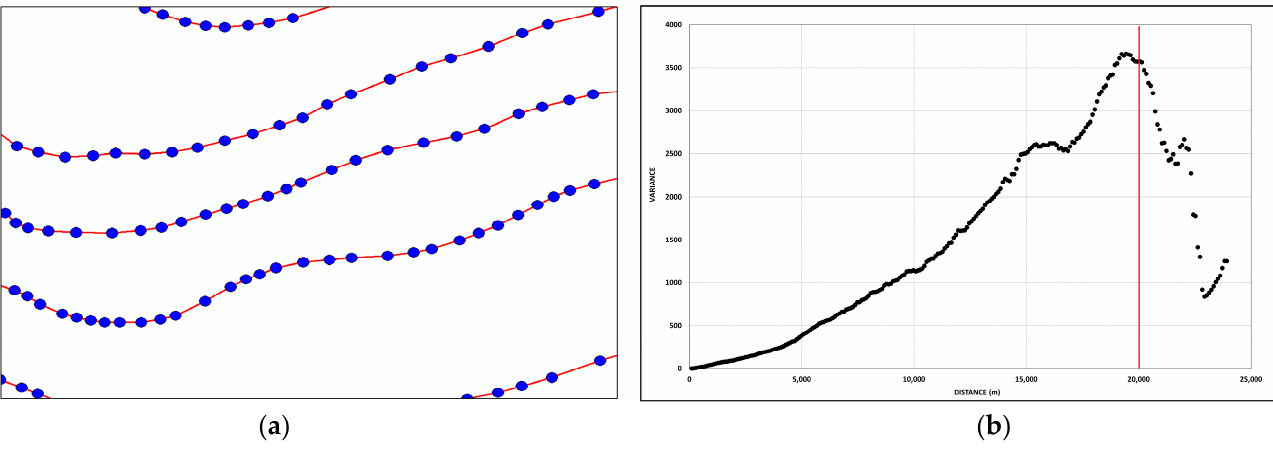
Figure 9. ( a ) Contour lines mapping PH and the correspondent points used during interpolation. ( b ) Variogram from PH values testifying that a spatial autocorrelation exists (range is about 20 km). Similar results were found for AF.